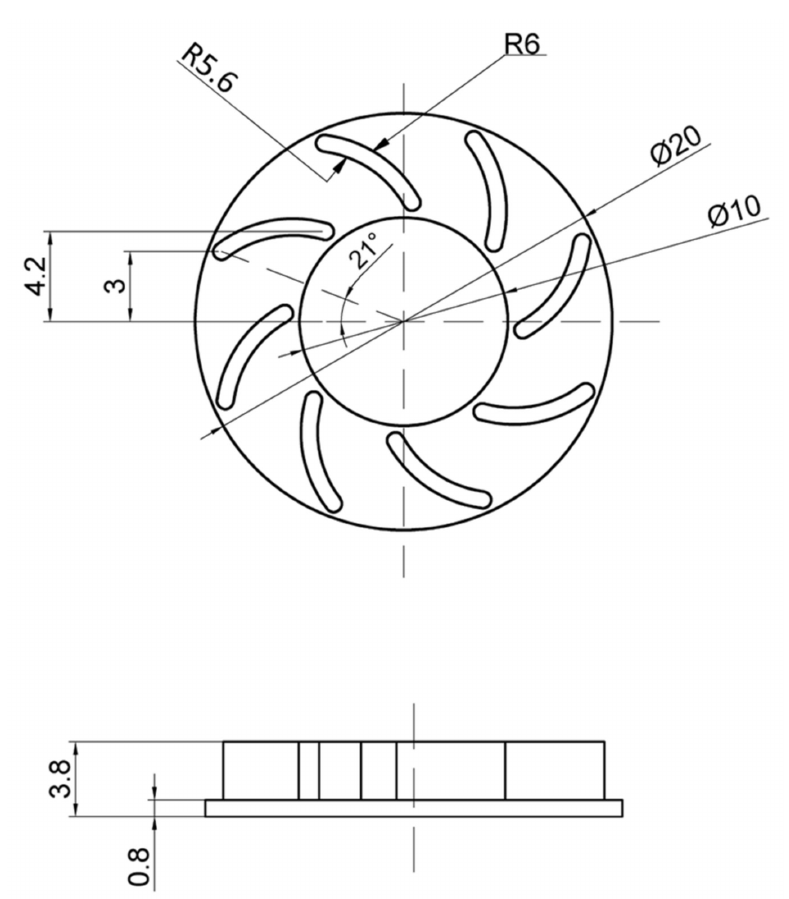
Figure 7. The dimensions of microproduct